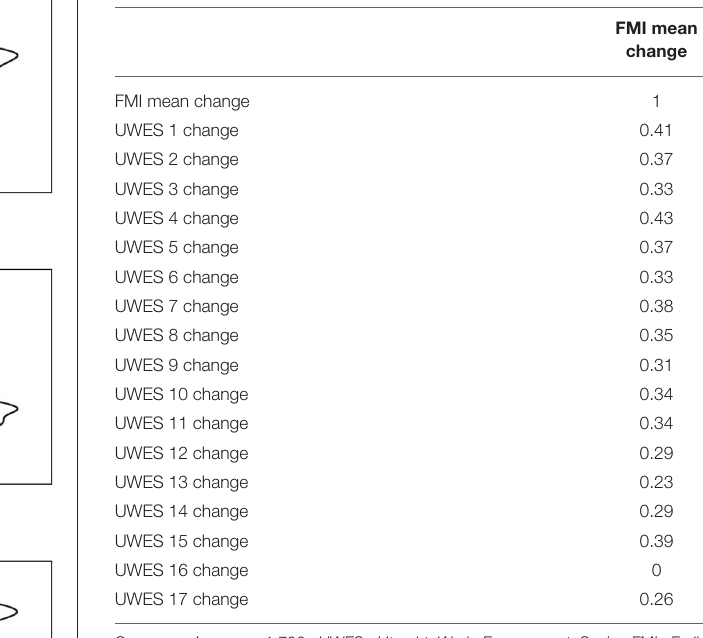
TABLE 3 | Test of associations between FMI change and UWES